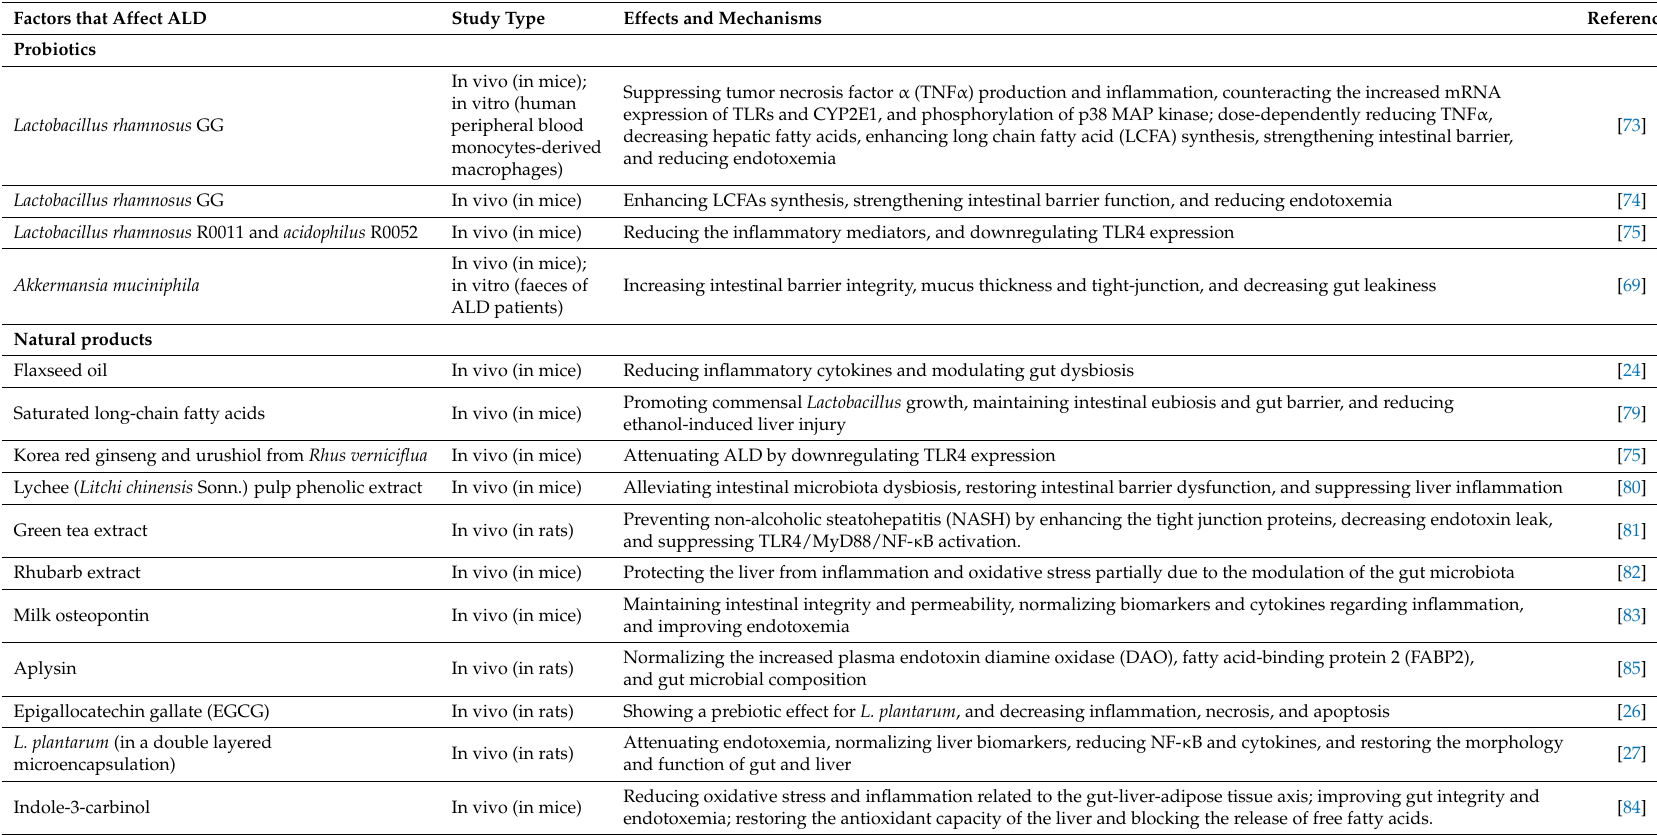
Table 2. Effects and mechanisms of natural products and probiotics on alcoholic liver disease (ALD) by modulating gut